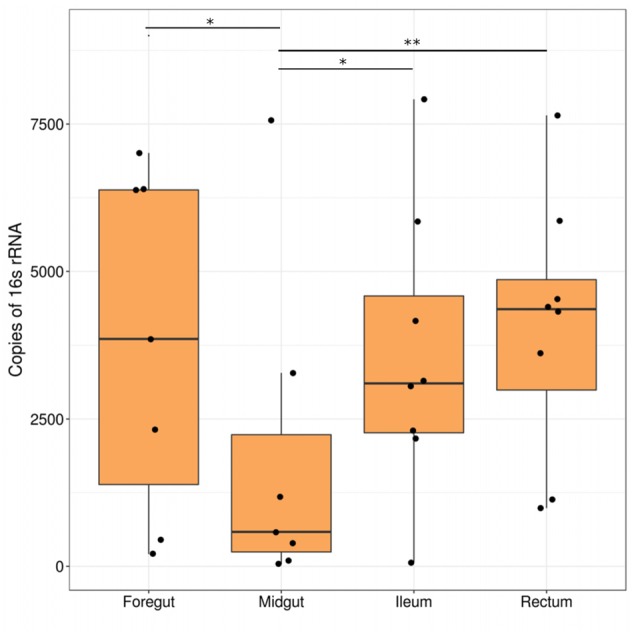
Abundance of bacterial 16S rRNA genes in field-caught Mormon crickets. Bars indicate significant differences between regions (∗p < 0.05, ∗∗p < 0.01).